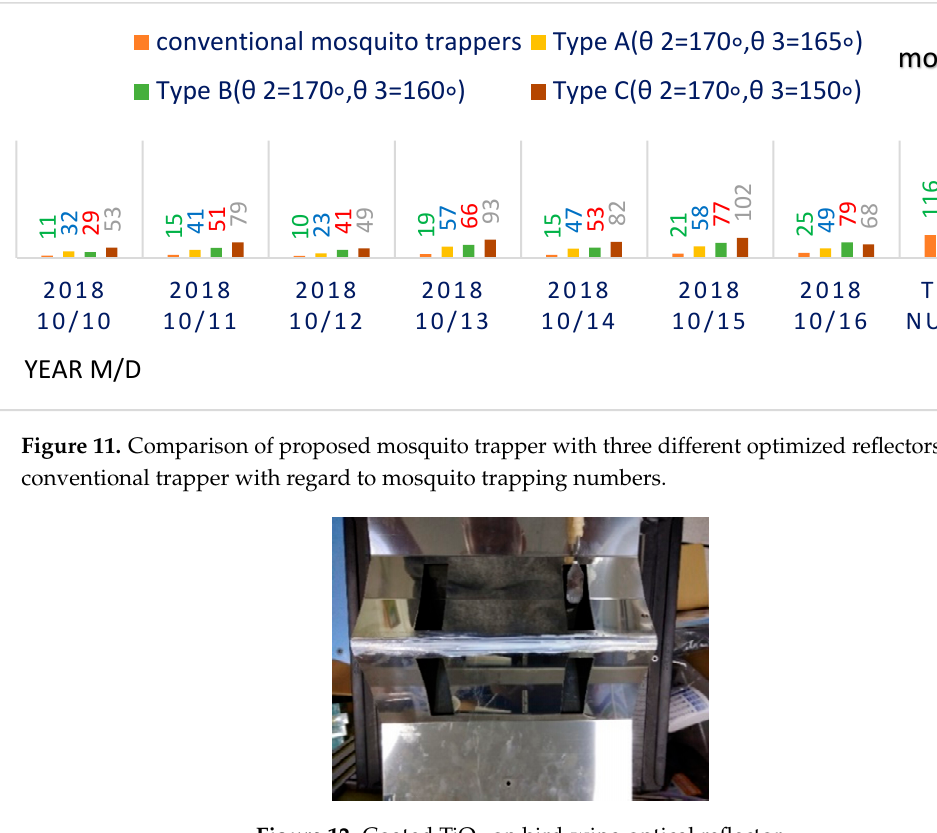
Figure 10. Conventional mosquito trapper and its mosquito trapping results.